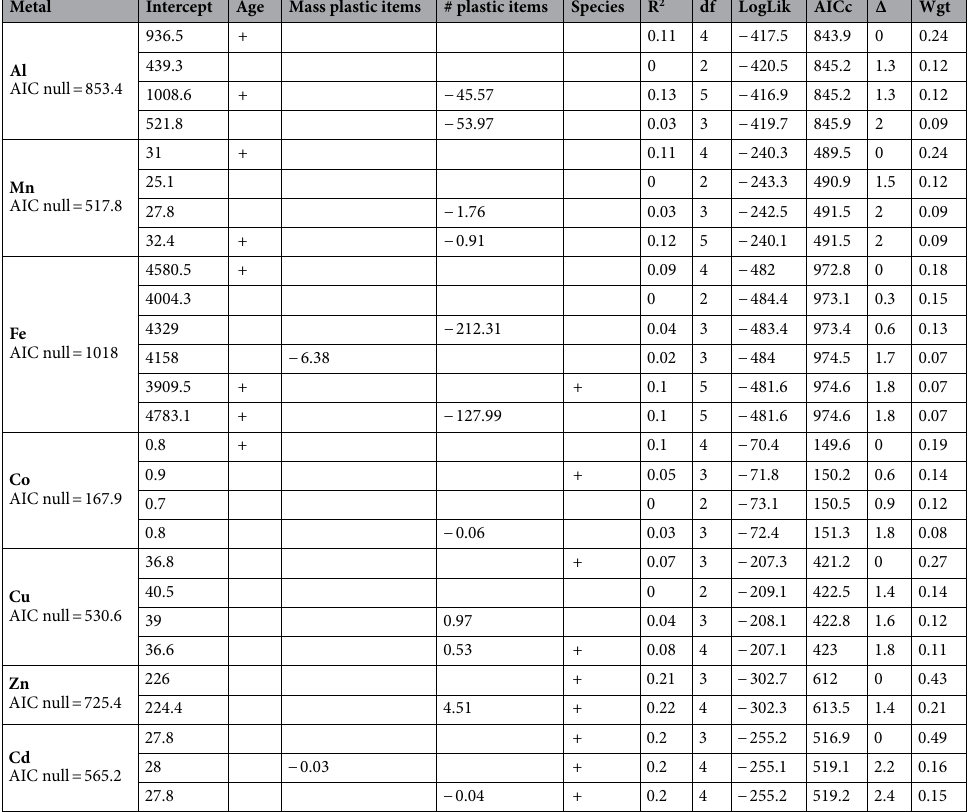
Table 2. General Linear Models (GLM) and model terms describing the relationship between liver metal(loid) concentration and age, mass of ingested plastic items / number of ingested plastic items and species. Models with a difference (Δ) in AIC of < 2 are considered equivalent models, and this table shows only models within 2 AIC of the best model (except Cd, where models within 3 AIC are shown). A ‘ + ’ sign denotes inclusion of the categorical variable in the model. Pachytila seabirds; fairy prion (n = 26) and slender-billed prion (n = 25) were collected dead in emaciated condition during a “seabird wreck”, New Zealand